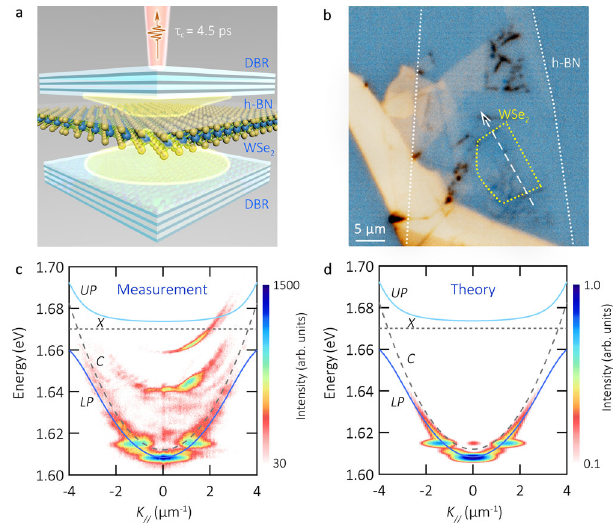
Fig. 1 Sample sketch and polariton dispersion relation. a Schematic of sample structure composed of two DBRs and an encapsulated monolayer of WSe 2 . b Optical microscope image of the sample. The WSe 2 monolayer (h-BN) is highlighted with dashed yellow (white) lines. A dashed white arrow indicates the slice resolved in the energy versus real space measures, the pump spot is placed in the centre of the monolayer. c Room temperature polariton dispersion relation encoded in a logarithmic false colour-scale. The pump power is 3 μ W. The dotted and dashed lines represent the bare exciton and microcavity modes, respectively. The resulting upper ( UP ) and lower polariton ( LP ) dispersion relations are shown as guides to the eye in light and dark blue colours, respectively. The exciton and photon modes are labelled X and C , respectively. The localised and bright emission modes at low energy arise from trapped polaritons. d Corresponding simulated dispersion relation of exciton-polaritons. The energies are obtained via solving Schrödinger ’ s equation for polaritons in a trap. The intensity is obtained assuming a thermal distribution of particles, and it is encoded in a logarithmic false